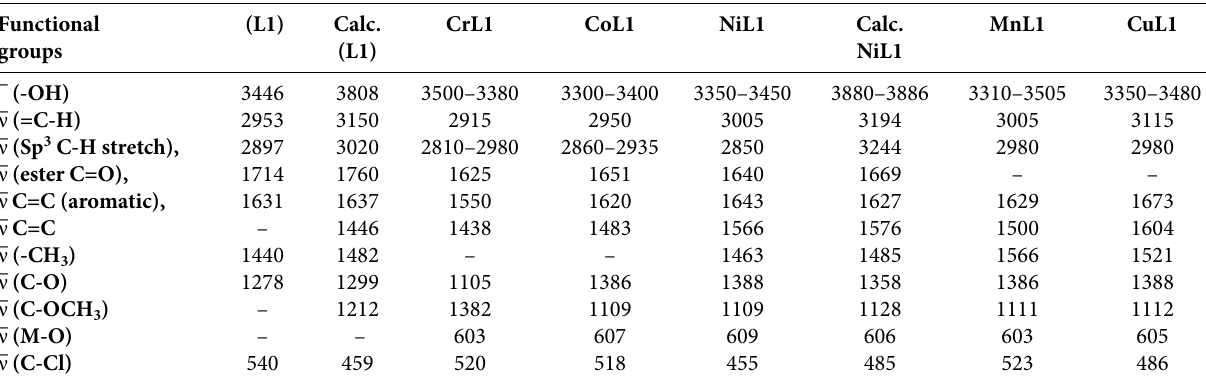
ν– Table 1. Characteristic FTIR bands of the MBHA (L1) and its metal complexes (cm −1 ) Functional (L1) Calc. CrL1 CoL1 NiL1 Calc. MnL1 CuL1 groups (L1)